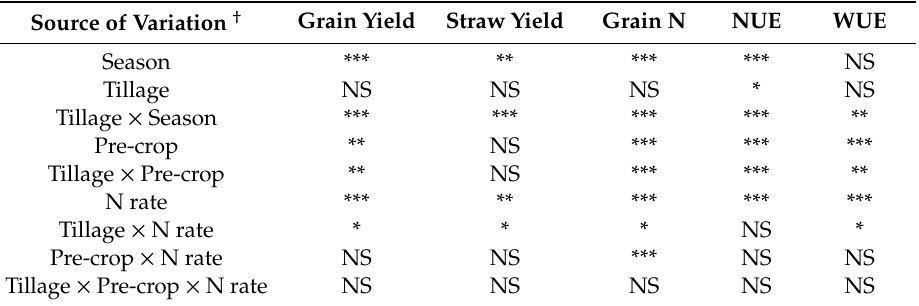
Table 2. Significance from ANOVA testing e ff ect of growing season (2013–2014 and 2014–2015), tillage practice (conventional and no-till), previous crop (bread wheat and vetch), and fertiliser N rate (N0, N1, N2, N3, and N4) and their interactions on grain yield, straw yield, N content in grains (Grain N), N use e ffi ciency (NUE), and water use e ffi ciency in grains (WUE) measured at physiological maturity of durum wheat. † Season, growing season; Tillage, tillage practice; Pre-crop, previous crop; N rate, nitrogen